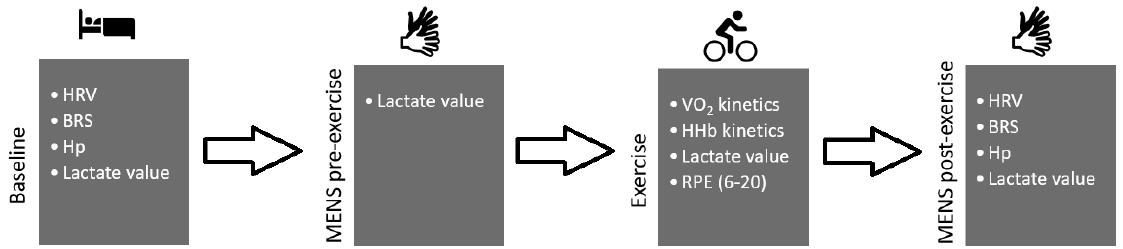
Figure 1. Graphical overview of the experimental protocol. HRV = heart rate variability, BRS = baroreflex sensitivity, Hp = hemodynamic parameters, MENS = microcurrent electrical neuromuscular stimulation, RPE = rate of perceived exertion, VO 2 = oxygen consumption, HHb = deoxyhemoglobin value. Gloves black and white represent active (ON) and inactive (OFF) stimulation, respectively.